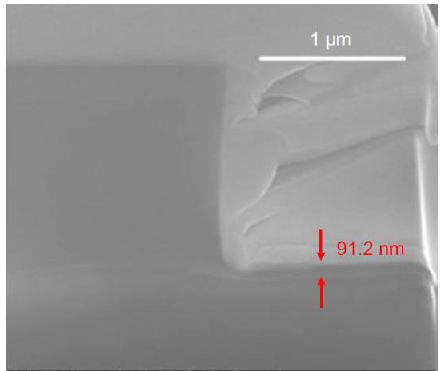
Figure 7. The SEM picture of the fabricated ridge shaped waveguide with negligible residual layer thickness [36].